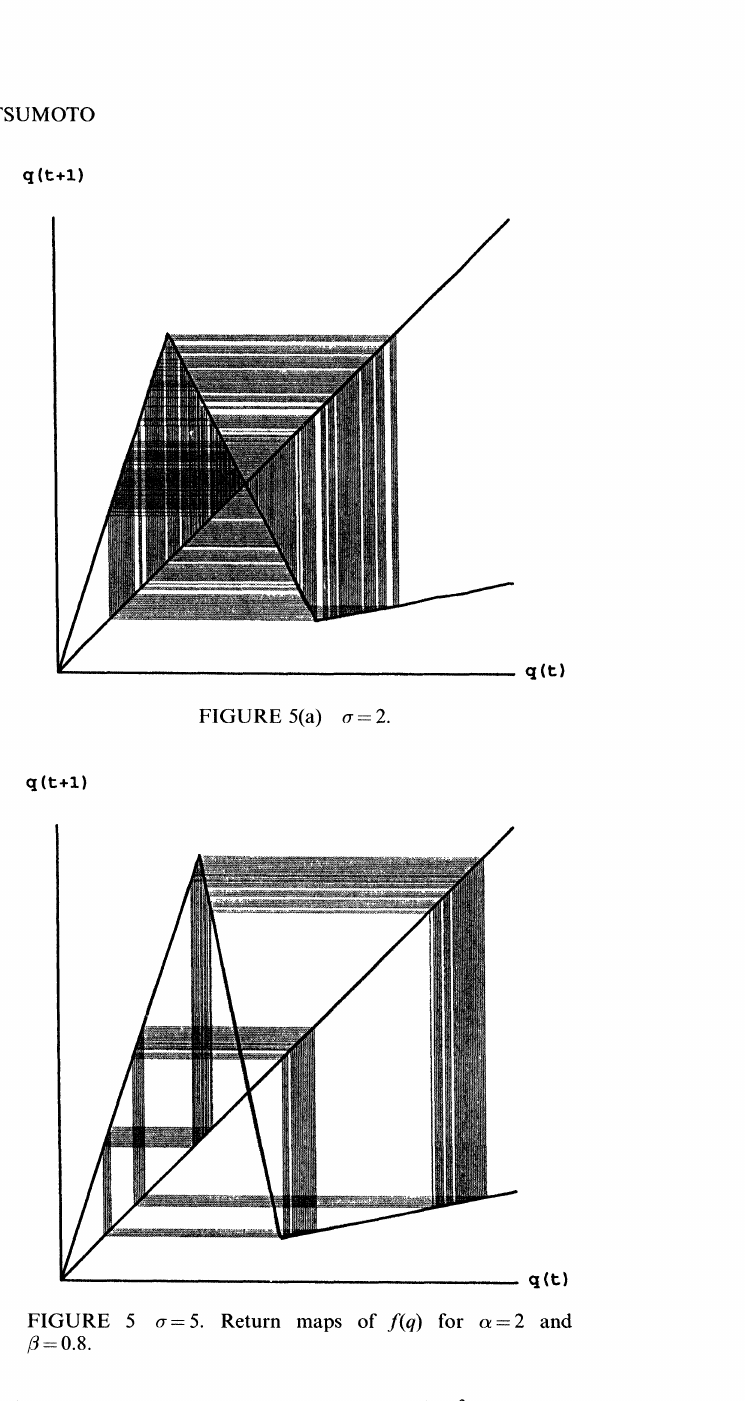
FIGURE 5 or=5. Return maps of f(q) for a=2 and